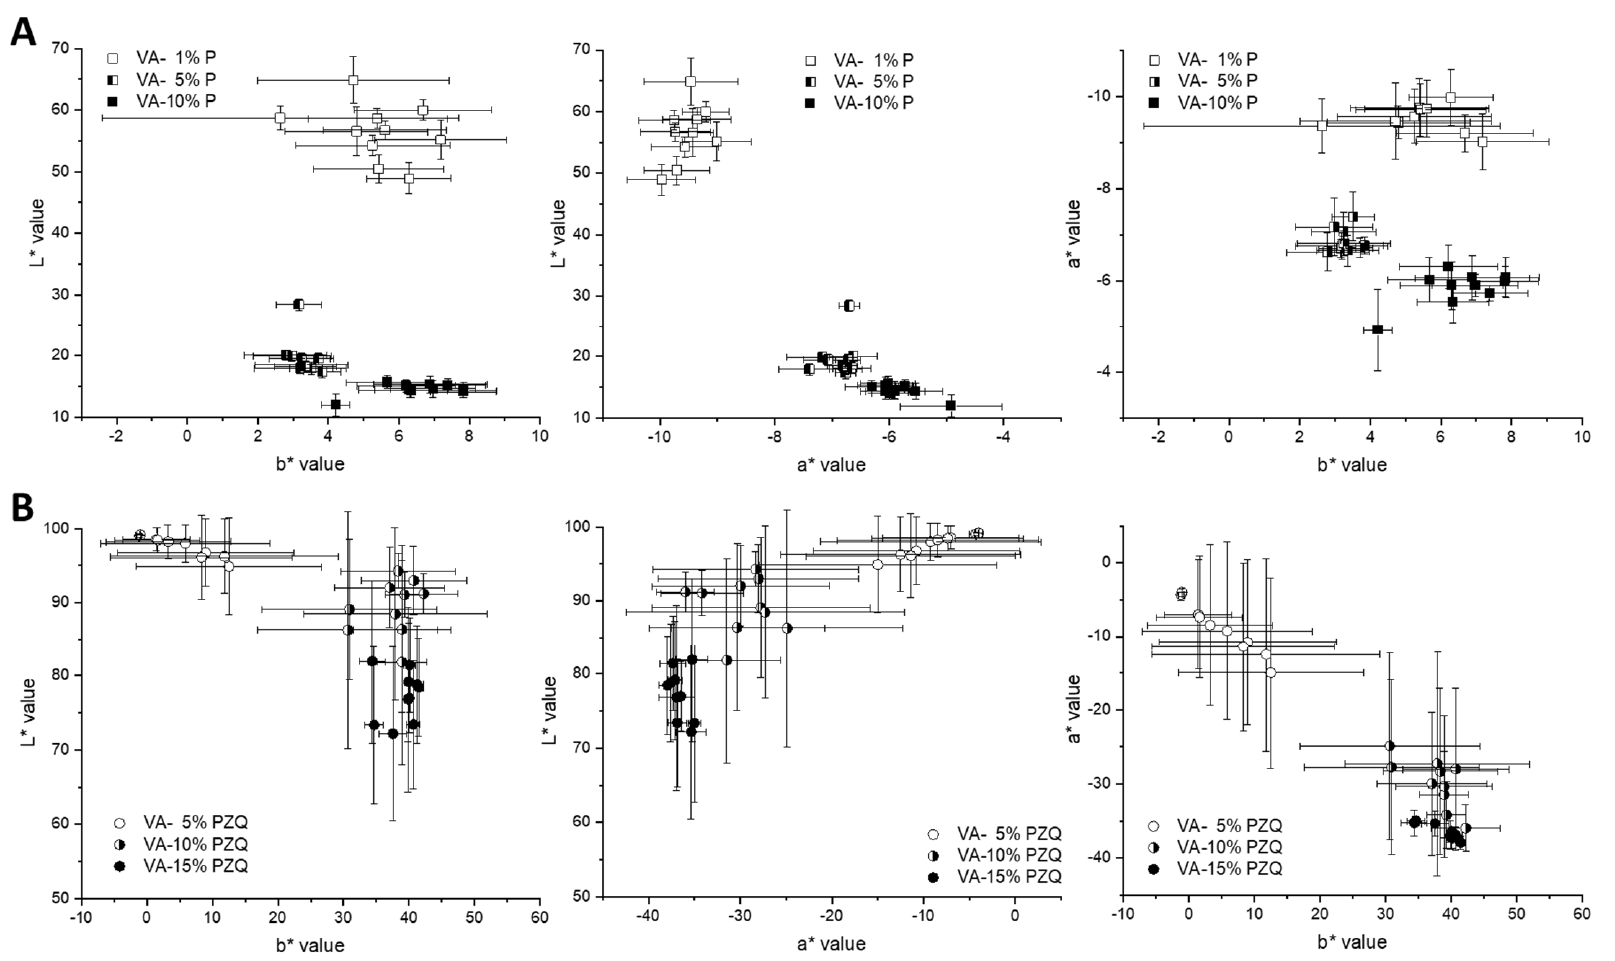
Figure 8. The 2D graphs of L*a*, L*b*, and a*b* values at 2.50 V for ( A ) pramipexole filaments (1, 5, 10% ( w/w )) and ( B ) praziquantel filaments (5, 10, 15% ( w/w )).